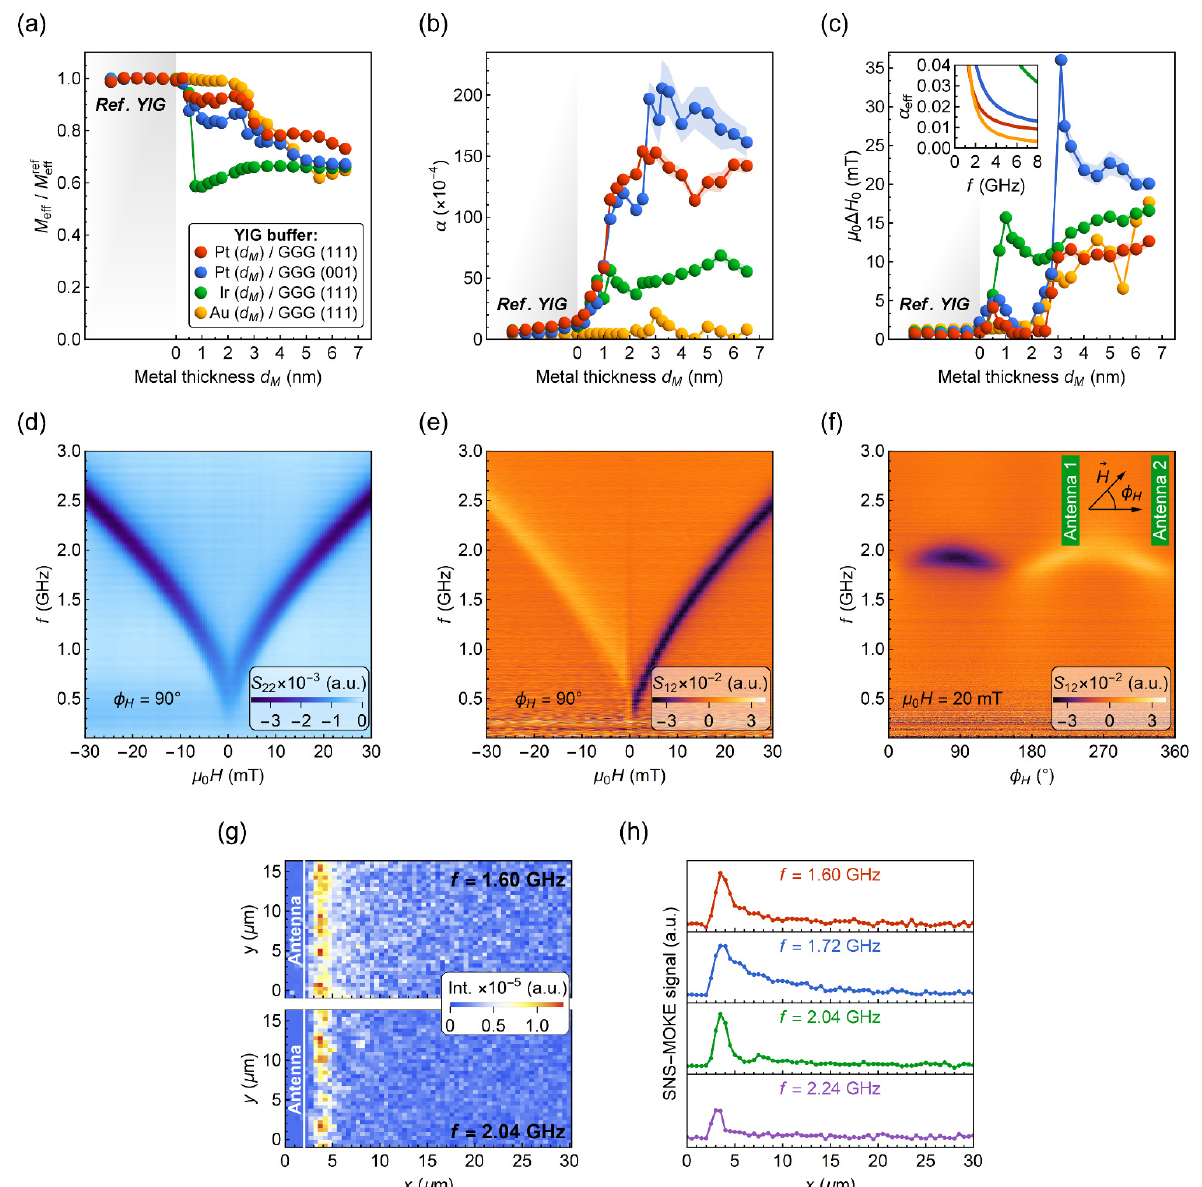
Figure 2. Broadband ferromagnetic resonance results for 40-nm-thick YIG films deposited on different metal underlayers with a nominal thickness d m . ( a ) Effective magnetization M eff normalized to M ref of a reference YIG film. ( b ) Gilbert damping parameter α . ( c ) Inhomogeneous linewidth broadening µ 0 ∆ H 0 . The inset shows calculated values of the effective damping parameter with Equation (3) for a 1-nm-thick metal layer. The color legend depicted in ( a ) also applies to ( b , c ). Values marked as reference YIG (shaded section) derive from measurements of the epitaxial film taken at the positions outside the metal wedge. ( d – f ) VNA spectroscopy results measured with lithographically patterned antennas for YIG (40 nm)/Au (3.0 nm)/GGG (111). ( d ) Color-coded reflection parameter S 22 showing the FMR absorption. ( e ) Color-coded transmission parameter S 12 for the magnetic field aligned parallel to the antennas ( φ H = 90 ◦ ). ( f ) Color-coded angular dependence of S 12 spectrum. Inset depicts in-plane magnetic field orientation with respect to the antenna geometry ( φ H = 0 ◦ for the magnetic field aligned perpendicular to the antenna edge). In figures ( d – f ), the real part of the scattering parameter S pq is plotted. ( g , h ) SNS-MOKE microscopy maps and line profiles recorded at µ 0 H = 20 mT for YIG (40 nm)/Au (3.0 nm)/GGG